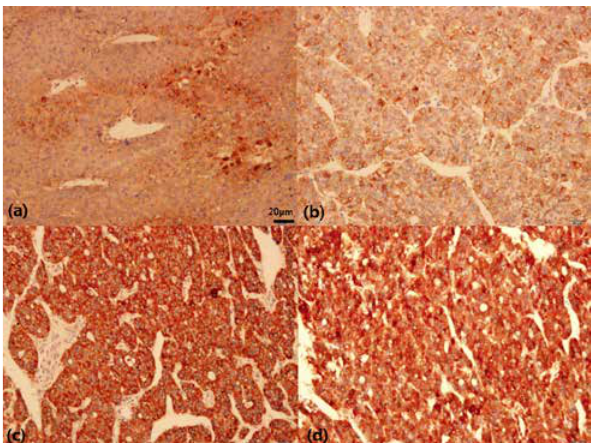
Figure 1: Results of immunohistochemical analysis in HCC. Expres- sion of (a) VEGF in the cytoplasm, (b) Akt, (c) HSP70 and (d) HSP27 in the cytoplasm and nucleus of cancer cells